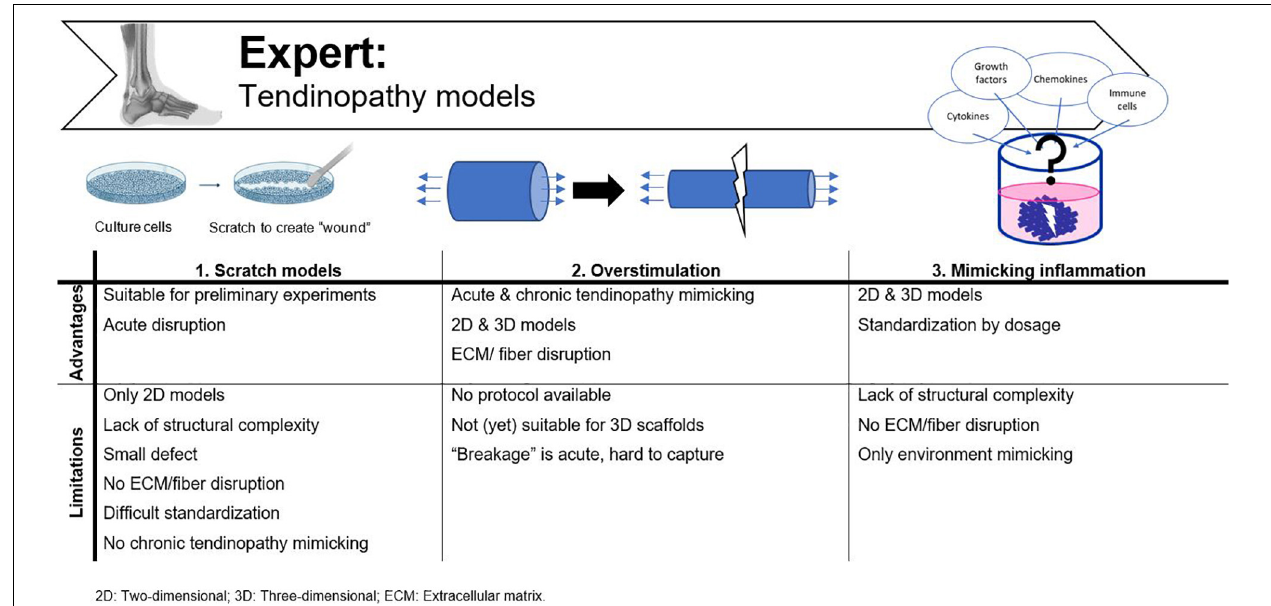
FIGURE 7 | Advantages and disadvantages of tendinopathy models currently used. Adjusted from Reaction Biology Corp. (n.d.).